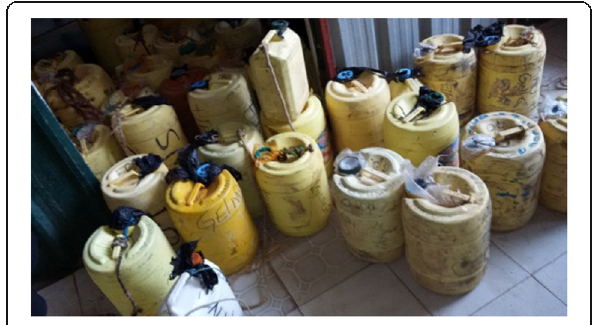
Figure 4 Milk in plastic containers at the reception of a milk collection centre in